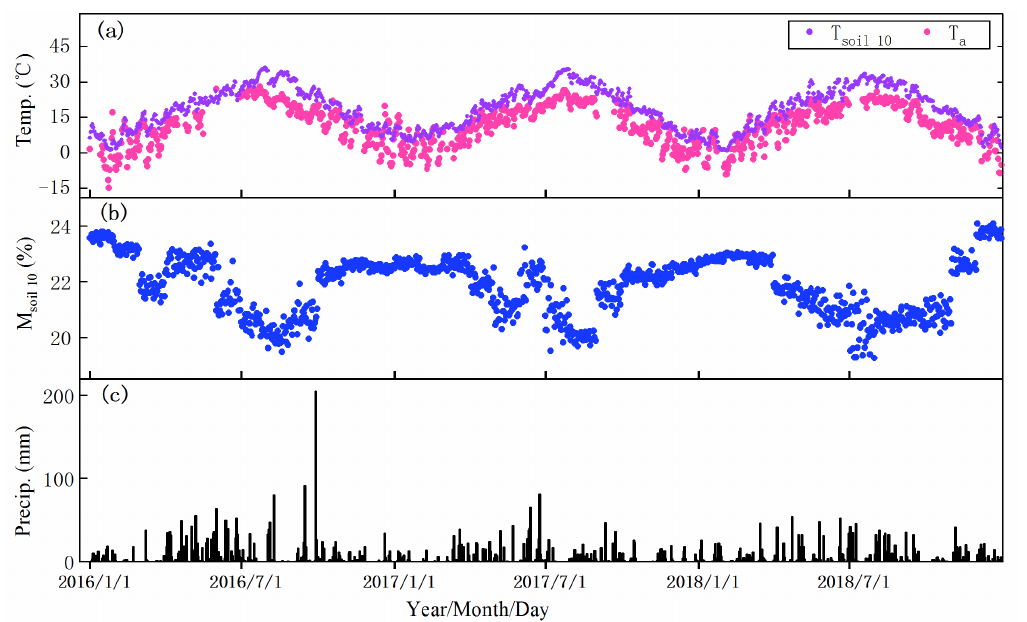
Figure 2. Daily average of environmental variables at the subtropical forest site during the study period, including air temperature (( a ), T a , pink), soil temperature at 10 cm depth (( a ), T soil 10 , purple), soil moisture (( b ), M soil 10 , blue) at 10 cm depth and precipitation (( c ), mm).